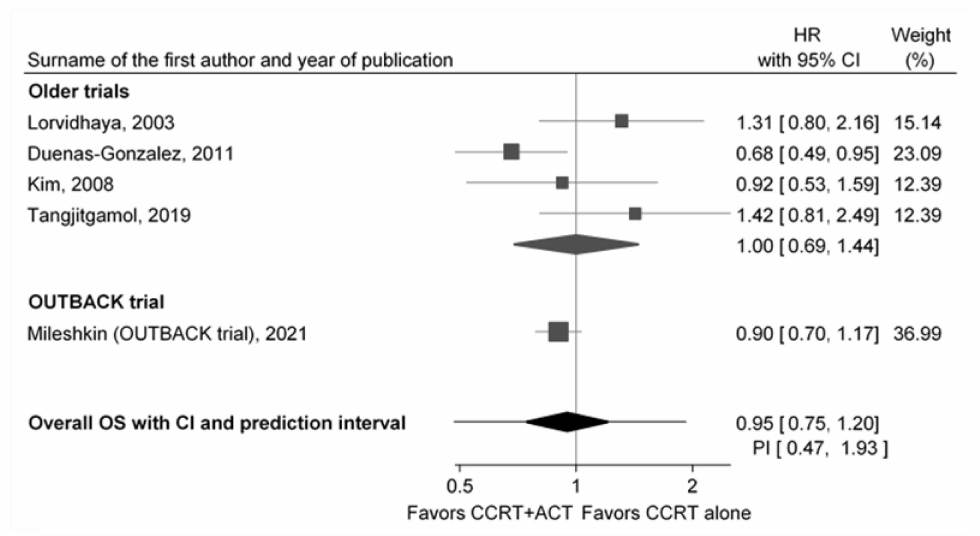
Figure 1. Forest plot of the effects of CCRT + ACT compared to CCRT alone on overall survival; gray squares represent each study hazard ratio (HR) for dying from any cause and whiskers represent 95% confidence intervals (CI); the size of the squares represent the weight of the study inverse to the study variance; black diamonds represent the pooled hazard ratio for older trials and for all trials (older and OUTBACK trial) calculated using a random effects model with a restricted maximum-likelihood method; whiskers from the lower “overall” diamond represent 95% prediction interval (PI); studies are sorted by the year of the end of